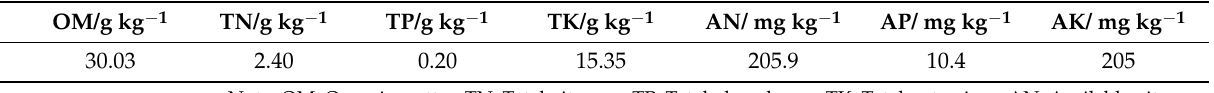
Figure 1. Dynamic changes of temperature and rainfall in the experimental area during double-cropping rice planting. Table 1. The original soil characteristics (0–20